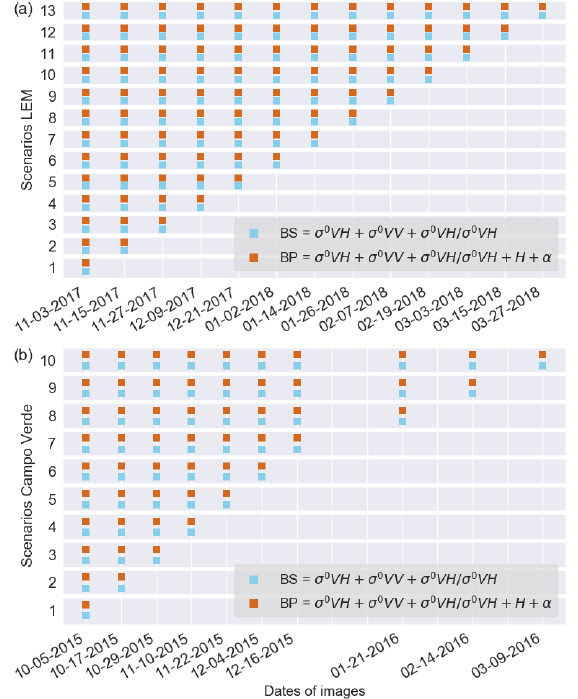
Figure 3. Date of images used in each classification scenarios for LEM (a) and Campo Verde (b): BS (Backscattering coefficients - σ 0 VH, σ 0 VV, and σ 0 VH/σ 0 VV) and BP (Backscattering coefficients + Polarimetric attributes - σ 0 VH, σ 0 VV, σ 0 VH/σ 0 VV, H, and α).